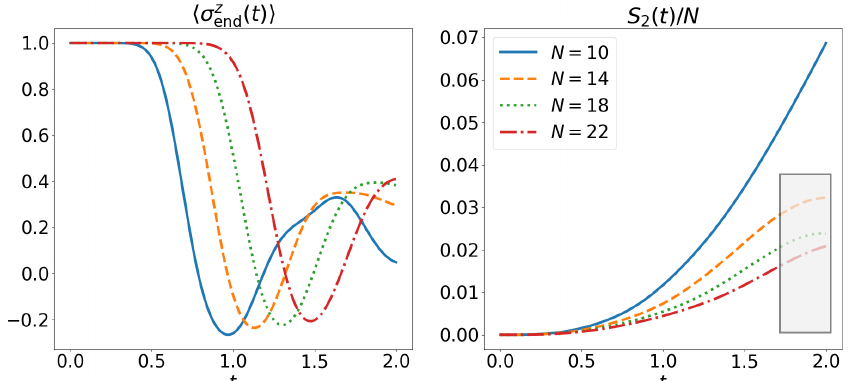
per qubit 2 can be 2 curve man- 2